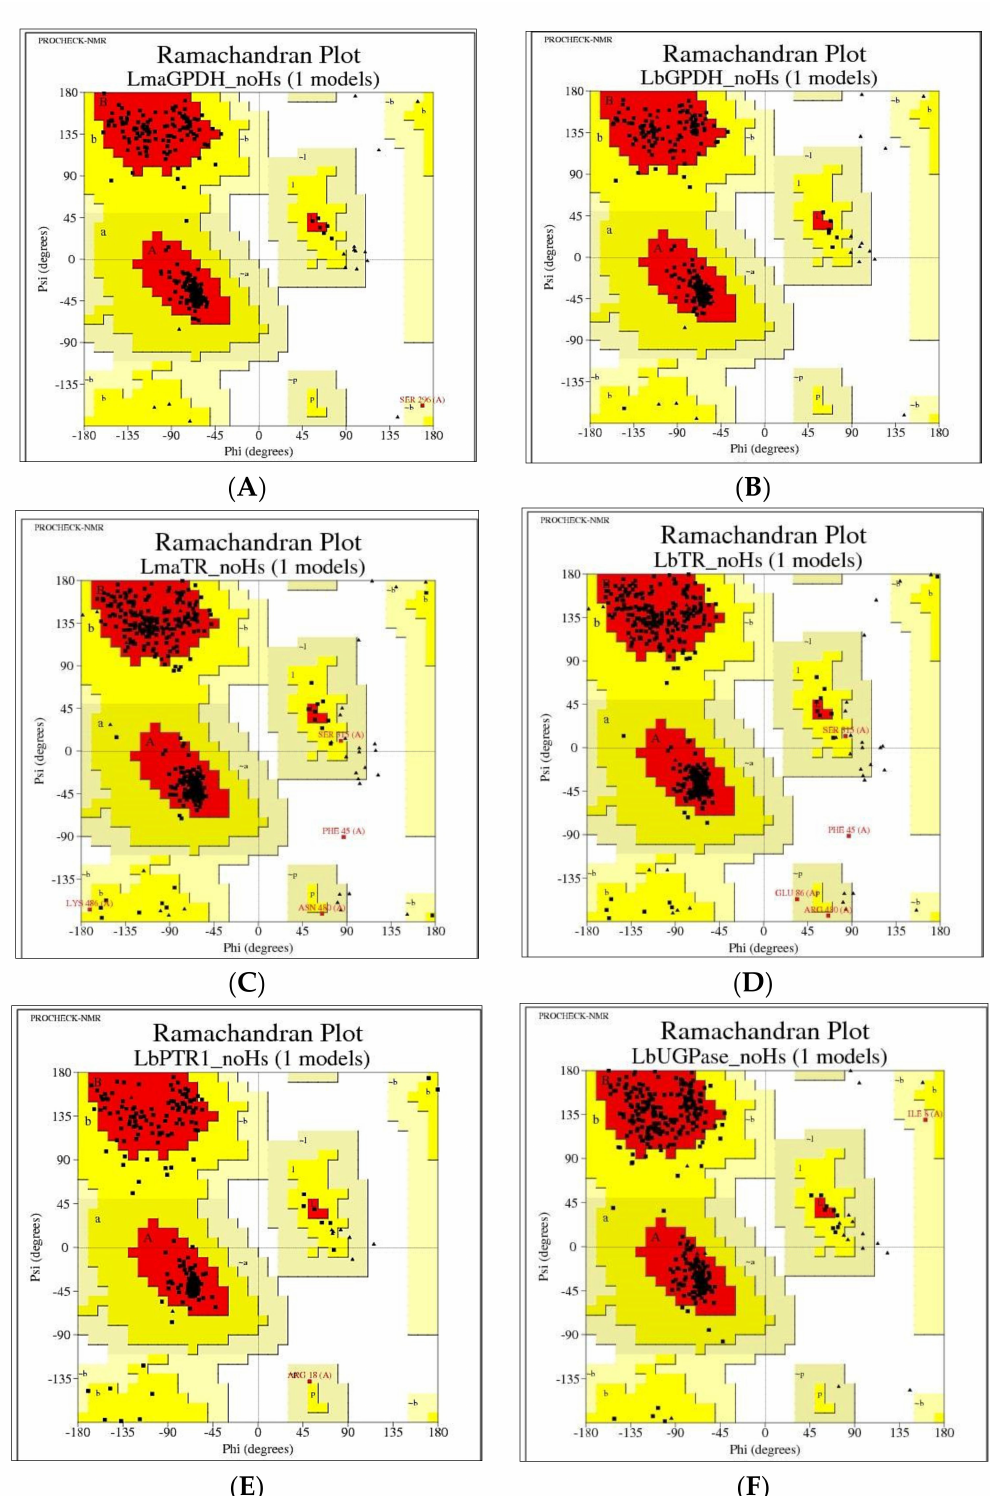
Figure 3. Ramachandran graphs of the homology models generated for L. major and L. braziliensis enzyme. The colored regions represent the permitted and favored regions of the secondary structures, and the white regions represent the prohibited regions. ( A ) Glycerol-3-phosphate dehydrogenase (GPDH) in L. major . ( B ) GPDH in L. braziliensis . ( C ) Trypanothione reductase (TR) in L. major . ( D ) TR in L. braziliensis . ( E ) Pteridine reductase 1 (PTR1) in L. braziliensis. ( F ) UDP-glucose pyrophosphorylase (UGPase) in L. braziliensis